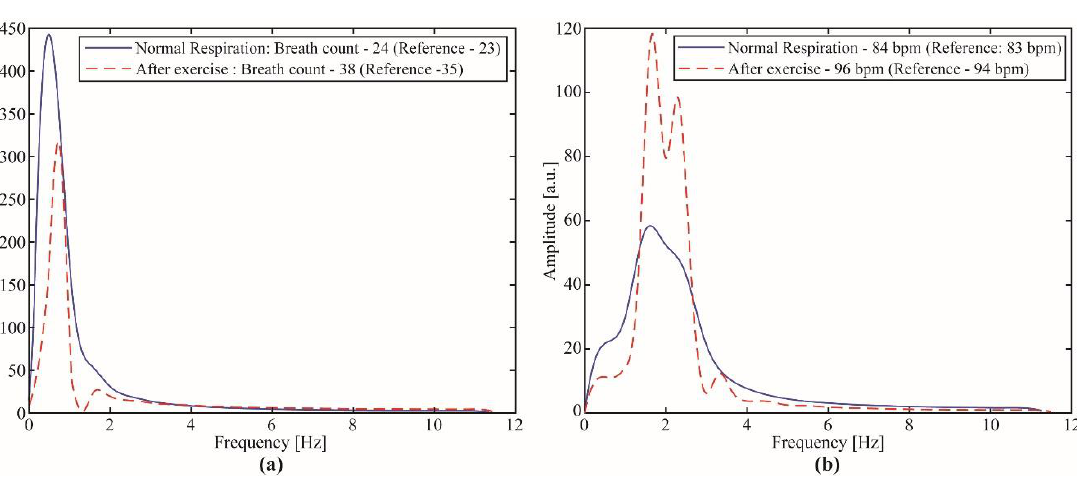
Figure 11. FPI-embedded smart textile for breath and heart rate responses under normal respiration and after exercise: ( a ) Breath count estimation (per minute); ( b ) heart rate estimation (in bpm—beats per minute).